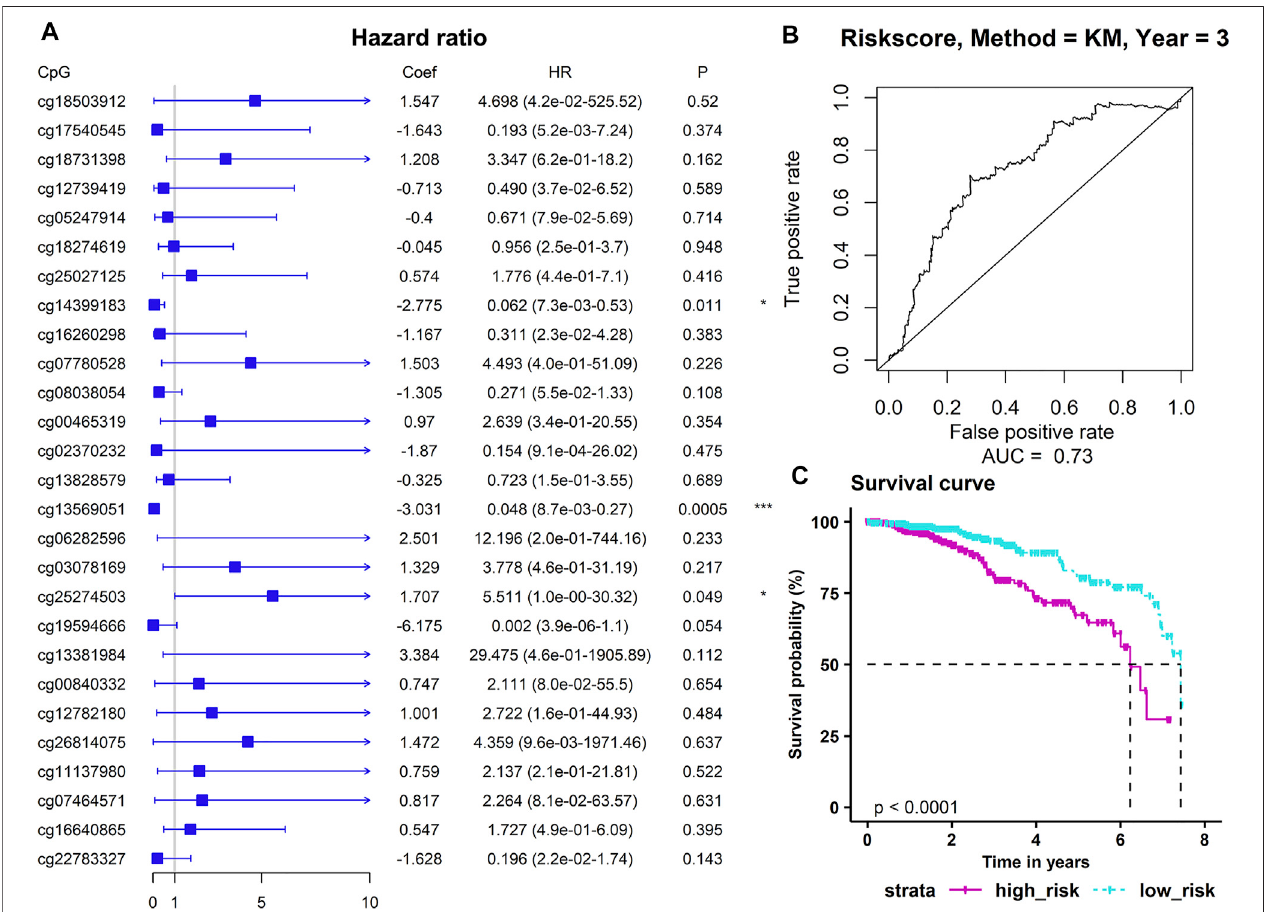
FIGURE6| Constructionofaprognosticmodel. (A) TheresultsofmultivariateCoxregressionanalysis. p -valueswereshownas:* p < 0.05;** p < 0.01;*** p < 0.001. (B) The sensitivity and speci fi city of the survival time of the sample. (C) The abscissa indicates the survival time (years), and the column indicates the survival rate.